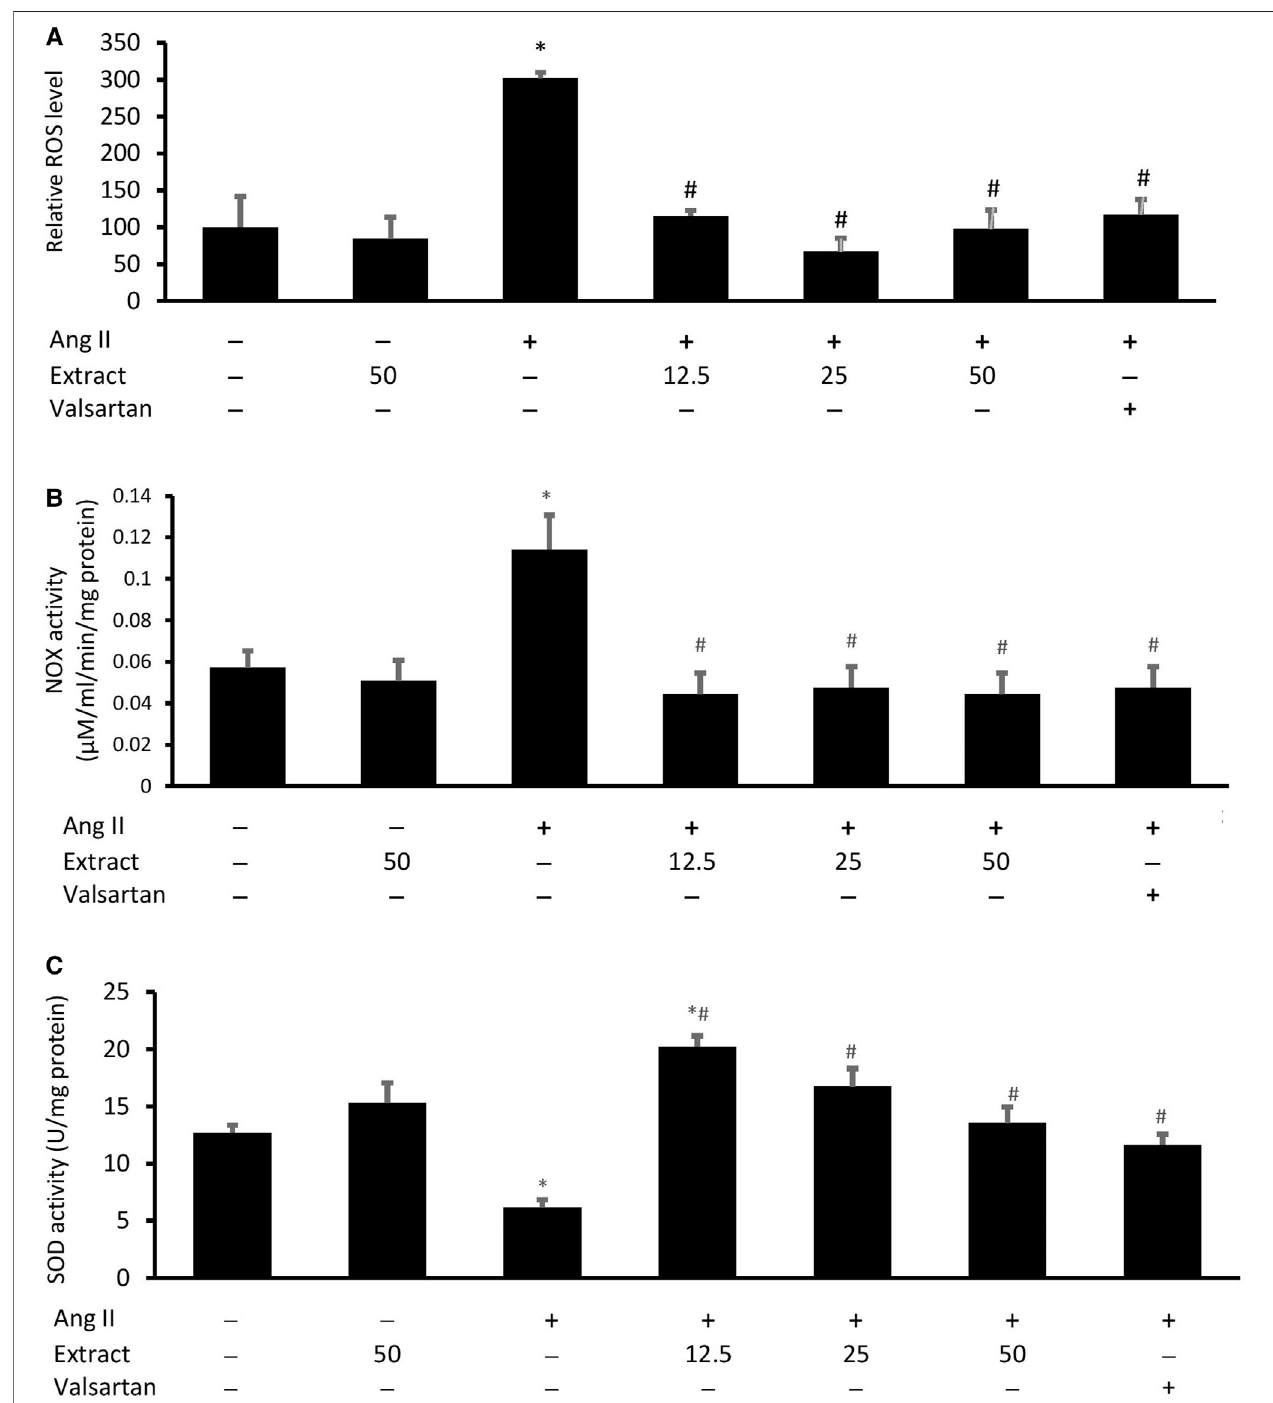
FIGURE 8| (A) Cellular reactive oxygen species (ROS) level, (B) NADPH oxidase (NOX) activities, and (C) superoxide dismutase (SOD) activities incells co-treated with Ang II (600 nM) and three concentrations of Parkia speciosa extract ( μ g/ml) or valsartan (20 μ M, positive control) for 24 h * p < 0.05 vs. control (no treatment) group. # p < 0.05 vs. Ang II group. Bars represent means ± SEM ( n (cid:2) 3).